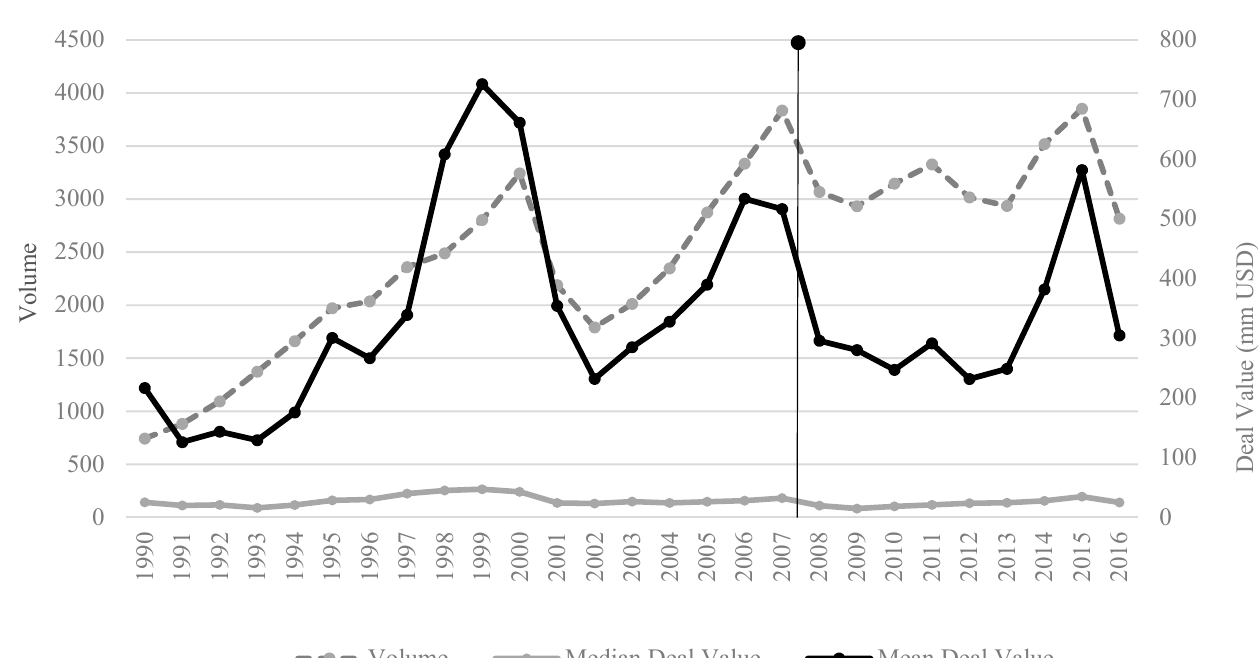
Figure 2. Line chart showing the trend in deal volume and deal value for global M&A between 1990 and 2016. The dotted line (left) shows global deal volume by year. The solid lines show the mean (black) and median (grey) deal values (right) of global M&A transactions by year.